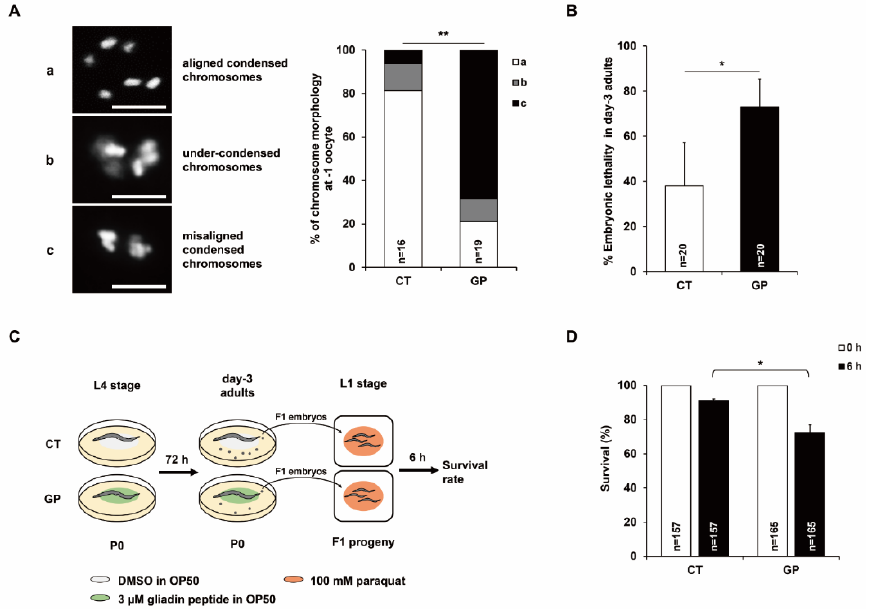
Figure 2. Chromosomal aberrations in the oocytes, embryonic lethality, and oxidative stress sensitivity in offspring are increased by GP intake. ( A ) Chromosomal morphology was observed using DNA staining. The type of aberration was classified into three categories depending on the condensation of chromosomes: aligned and condensed (a), under-condensed (b), and misaligned and condensed (c). The graph indicates the chromosomal morphology of -1 oocytes produced from control (CT) or GP-treated adult worms. Scale bars are 10 µm. ** p < 0.05 (chi-square test). ( B ) The graph indicates the percentages of unhatched embryos for 24 h in day-3 adult-stage worms treated with 0 (CT) or 3 µM of GP. Error bars represent SD. * p < 0.05 (Student’s t -test). ( C ) Experimental scheme for survival assay against 100 mM paraquat (PQ) in the offspring produced from DMSO-treated (CT) or GP-treated worms (GP). ( D ) The graph indicates survival rate in the F1 progenies produced by worms treated with 0 (CT) or 3 µM GP and 100 mM PQ for 6 h. Error bars represent SD. * p < 0.05 (two-way ANOVA with Tukey’s post hoc test).